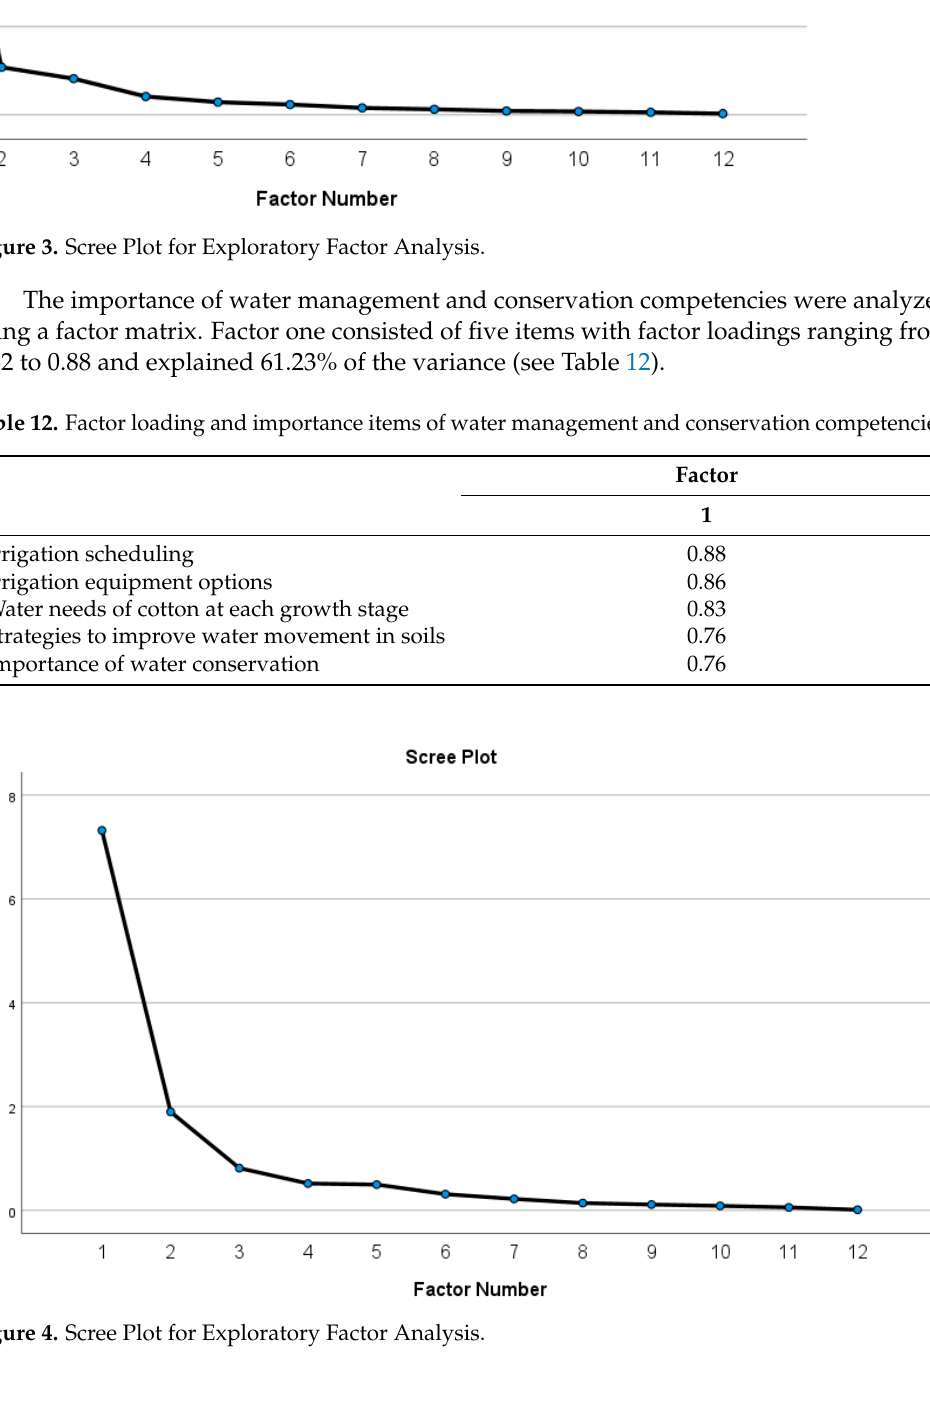
factor matrix. Factor one consisted of twelve items with factor loadings ranging from 0.71